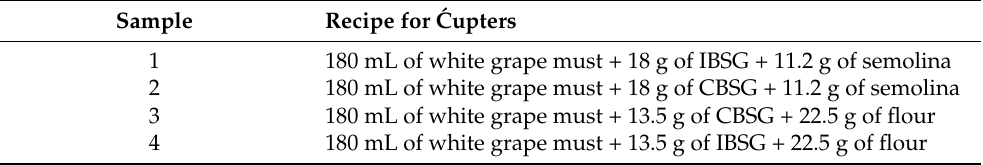
Table 1. The recipe used for preparation of traditional and modified traditional ´cupter.